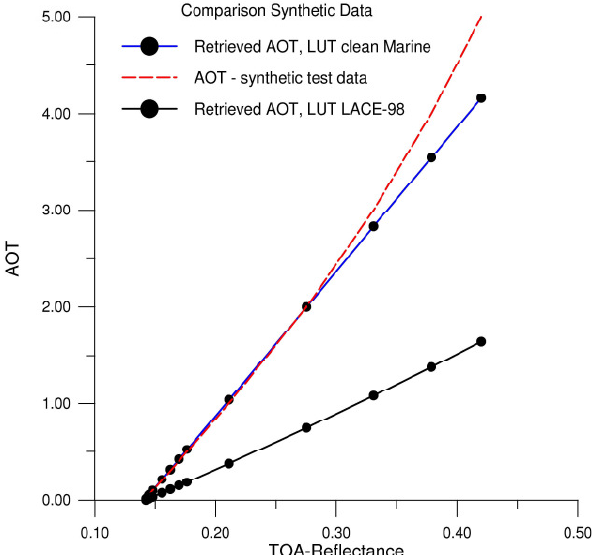
Fig. 20. Instrument degradation according 4. and 5. reprocessing in comparison with the lunar calibration of the SeaWiFS